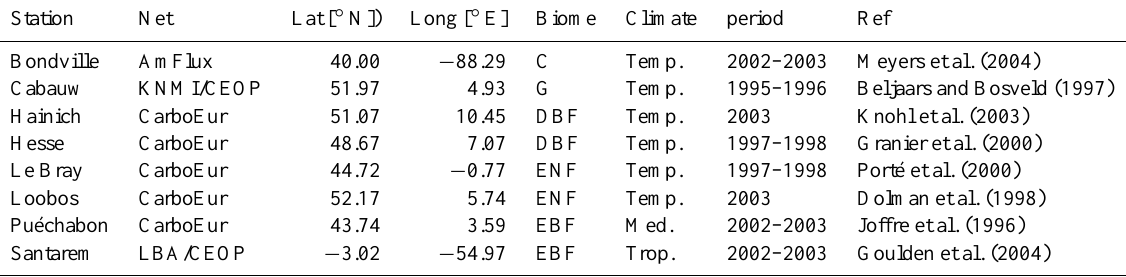
Table A1. Flux stations. Network (Net): AmeriFlux (AmFlux), Koninklijk Nederland Meteorologische Instituut (KNMI), Coordinated En- ergy and water cycle Observations Project (CEOP), CarboEurope (CarboEur), Large-Scale Biosphere-Atmosphere Experiment in Amazonia (LBA). Latitude (Lat), Longitude (Long). Biome types: crops (C), grassland (G), deciduous broadleaf forest (DBF), evergreen needle leaf forest (ENF), evergreen broadleaf forest (EBF). Climate: temperate (Temp), Mediterranean (Med), tropical (Trop). Period (years). Reference (Ref). Station Net Lat [ ◦ N]) Long [ ◦ E] Biome Climate period Ref Bondville AmFlux 40.00